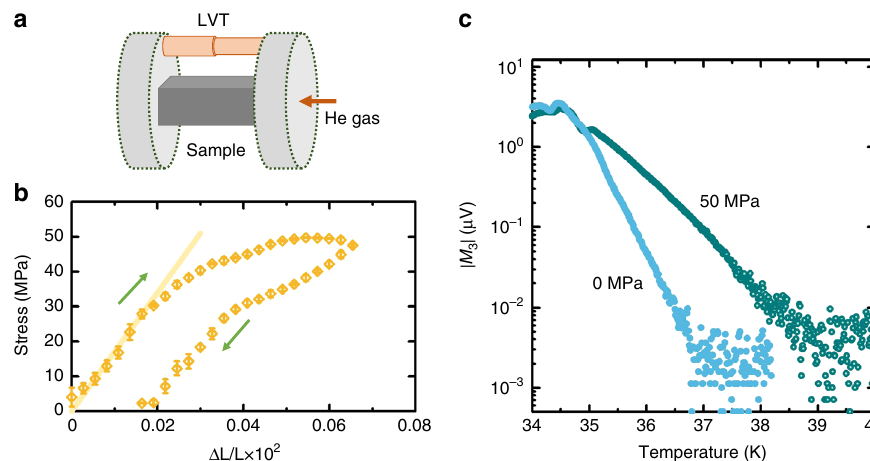
Fig. 3 In fl uence of stress-induced inhomogeneity. a Schematic representation of the uniaxial pressure experiment, where a controlled force is applied to the sample with a helium gas piston (right disk), whereas the other side is static (left disk). The sample deformation is measured independently using a linear variable transformer (LVT). b Ambient temperature stress-strain diagram for a LSCO sample with Sr doping level slightly below 14% (from a different growth than the sample in Fig. 2). The deviation from linear behaviour and the hysteresis clearly show that the plastic regime is reached, thus inducing structural inhomogeneity (defects) to accommodate plasticity. Multiple pressure readings were acquired at each deformation, and error bars are one standard deviation from the mean. The line corresponds to a Young modulus of 170 GPa, in good agreement with the value obtained from ultrasonic measurements of the elastic tensor components, 181 GPa (ref. 22 ). c Nonlinear magnetization measurements before (full circles) and after (empty circles) the application of stress at room temperature. The stress-induced inhomogeneity has a strong in fl uence on the slope of the exponential temperature dependence, and thus establishes its structural origin. Note that the slope of the unstressed sample is the same as in Fig. 1, which demonstrates a high